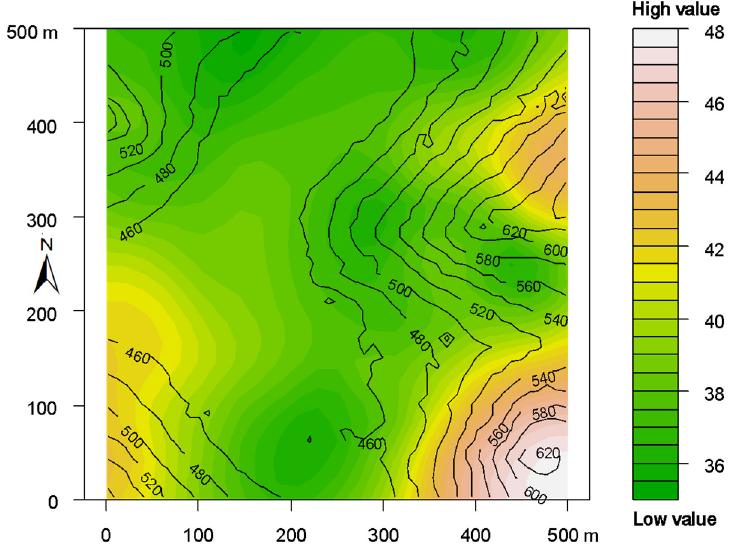
Figure 3. Spatial distribution of forest aboveground biomass ( AGB) in the Mulun plot. Contour lines in the map indicate elevation. White indicates values higher than the median, and green indicates values less than the median.